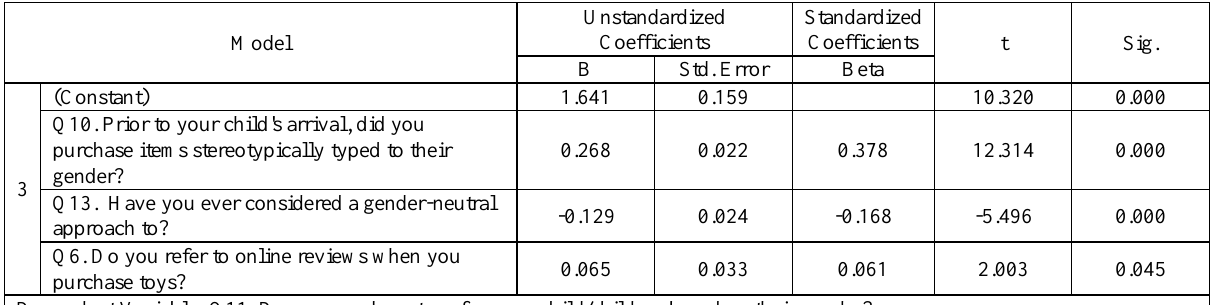
Table 7. Coefficients of the regression